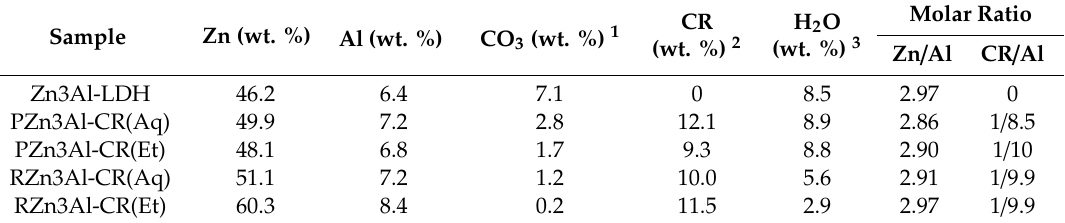
Table 1. Chemical composition of the